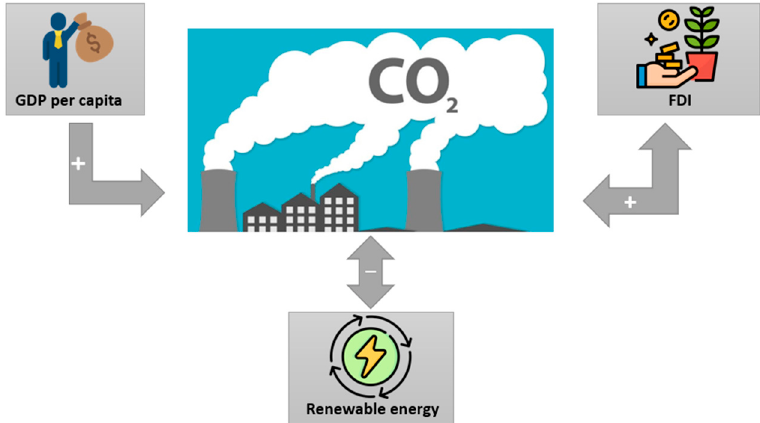
Figure 3. Graphical results of the study.